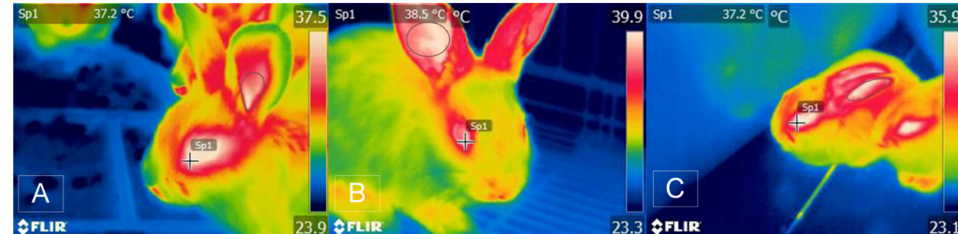
Figure 2. Rabbit thermograms before, during, and after being subjected to a transport simulation model. ( A ) The specimen is observed before being subjected to vibratory stimulation with a tempera- ture of 37.2 ◦ C in the lacrimal caruncle and a surface temperature of more than 37 ◦ C in the periocular region and part of the pinna (indicated with an oval). ( B ) The specimen is subjected to a vibratory stimulus for 10 min, at an intensity of 4 Hz, with the presence of a 1.3 ◦ C higher temperature in the lacrimal caruncle and increase of approximately 2.9 ◦ C by 70% of the surface of the pinna (indicated with an oval). ( C ) The specimen is seen in the recovery phase, 20 min after having been subjected to the transport simulation model, at again 37.2 ◦ C in the lacrimal caruncle and a temperature of the ear 4 ◦ C lower than in thermogram ( B ). Comparing the thermograms, it is concluded that the rabbit presented a transient and monophasic hyperthermic response due to the effect of the stress generated through the stimulus of vibrations, since its temperature gradually decreases until it returns to its basal state once the stimulus has ended. Images obtained with an FLIR E 50 camera equipped with an 18 mm FOL lens at a resolution of 240 × 180 pixels, (emissivity = 0.95, distance = 0.5